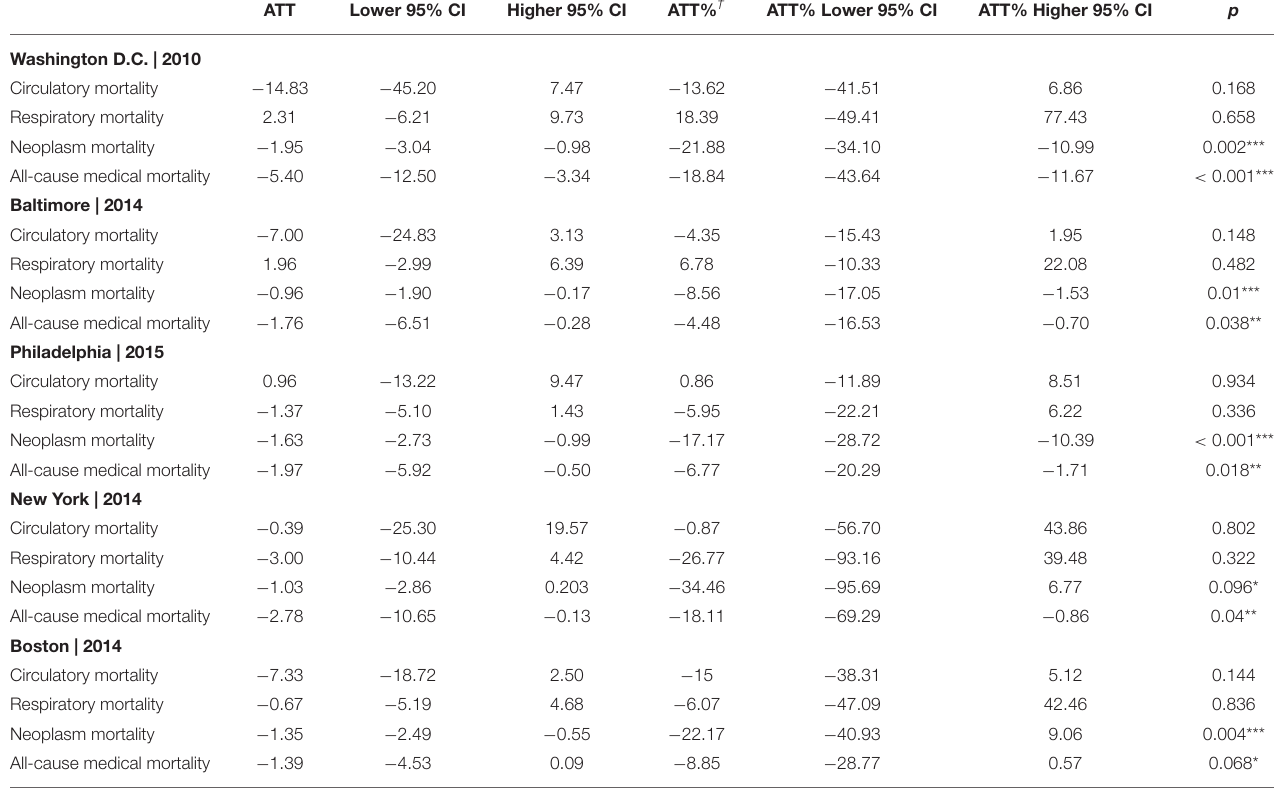
TABLE 2 | Treatment effects on mortality rates in treated cities.